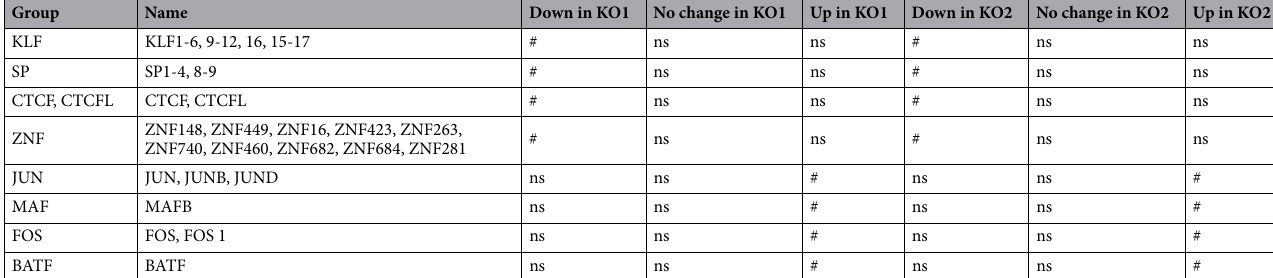
Table 3. Transcription factor binding sites associated with up- and downregulated genes. # p < 0.05; ns, not significant (TF binding sites are not significantly